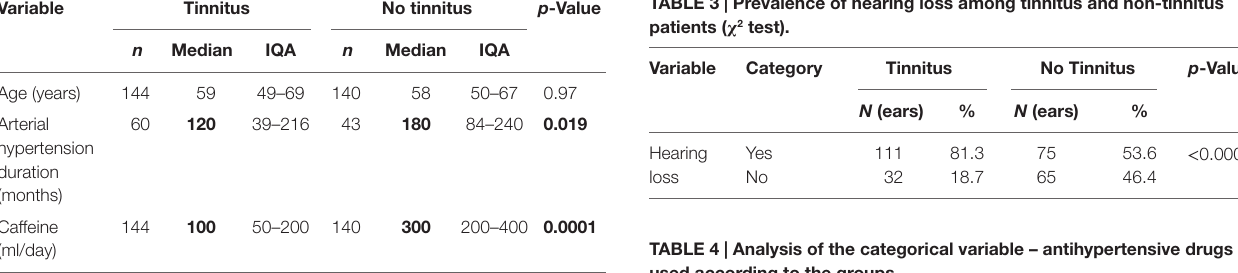
Table 1 | analysis of the numerical variables (age, duration of arterial hypertension, and daily consumption of caffeine) according to the group. Variable Tinnitus no tinnitus p -Value